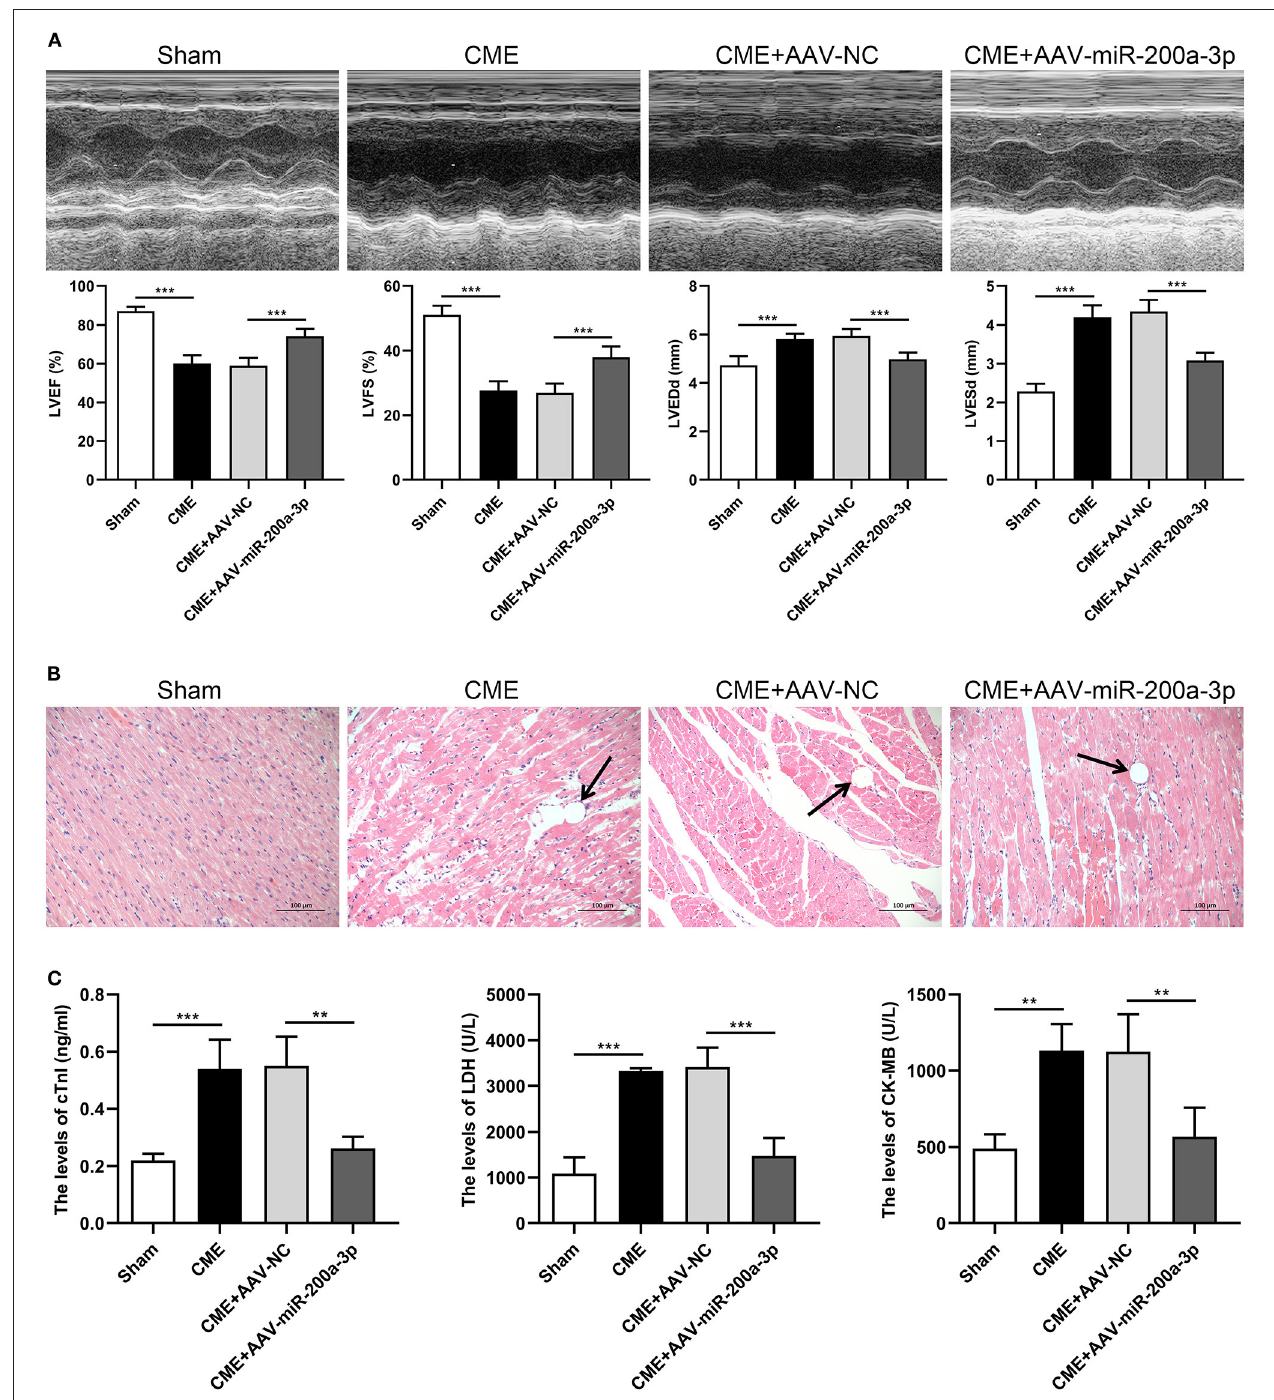
FIGURE 4 | miR-200a-3p overexpression alleviates CME-induced myocardial injury. (A) Echocardiographic analysis of cardiac function in each group ( n = 6 per group), and corresponding comparison of left ventricle ejection fraction (LVEF), left ventricle fractional shortening (LVFS), left ventricular end-diastolic diameter (LVEDd), and left ventricular end-systolic diameter (LVESd). (B) Histopathological analysis in each group by H&E staining ( × 200 magnification; bar = 100 µ m) ( n = 3 per group). (C) The serum levels of cTnI, LDH, and CK-MB in each group ( n = 4 per group). The data are presented as the mean ± standard deviation (SD). ** P < 0.01, *** P < 0.001. CME, coronary